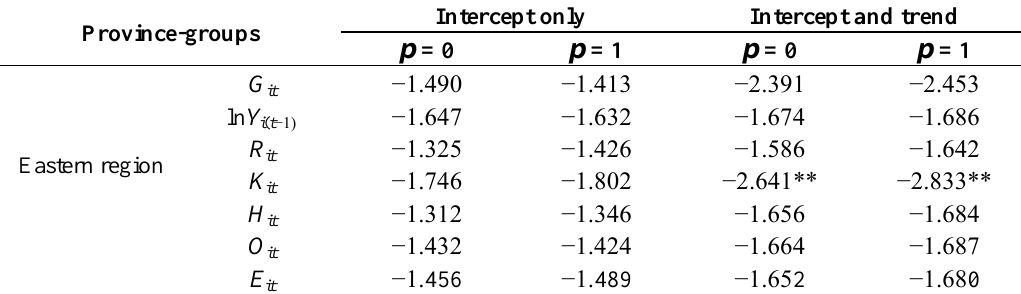
Table 2. Results of the unit root tests for cross sectionally dependent panels.